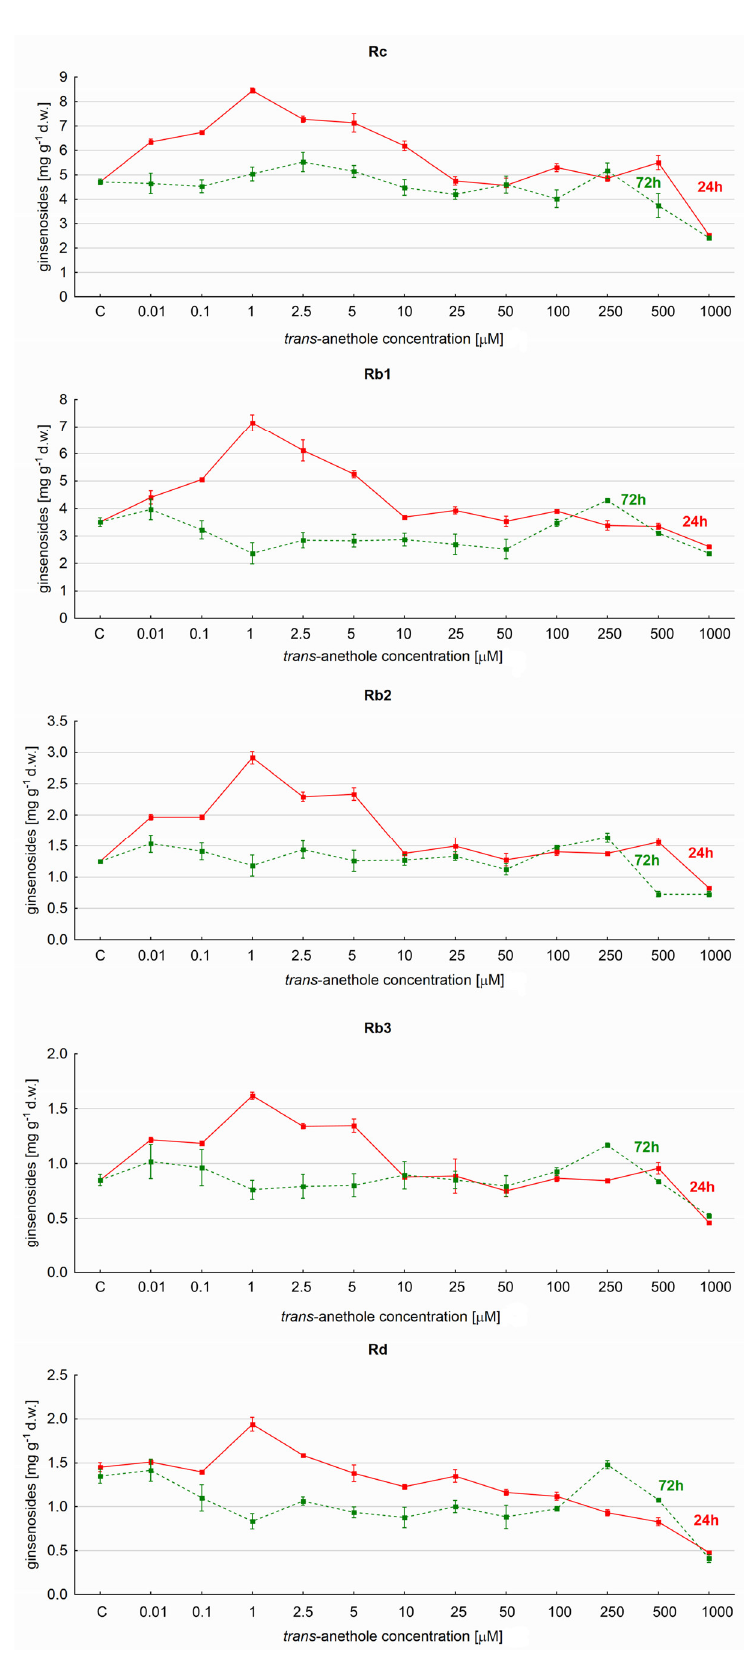
Figure 2. The effect of trans -anethole concentration on the production of Rc, Rb1, Rb2, Rb3 and Rd ginsenosides in Panax quinquefolium hairy roots after 24- and 72-h elicitation.